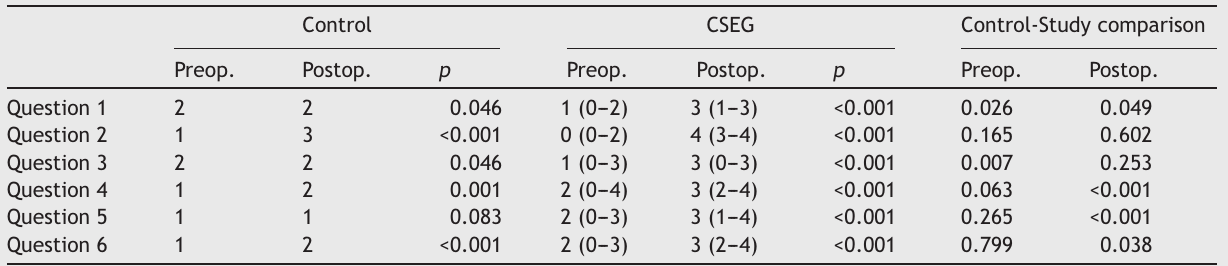
Rhinoplasty Outcome Evaluation (ROE) questionnaire results of the groups. Control CSEG Control-Study